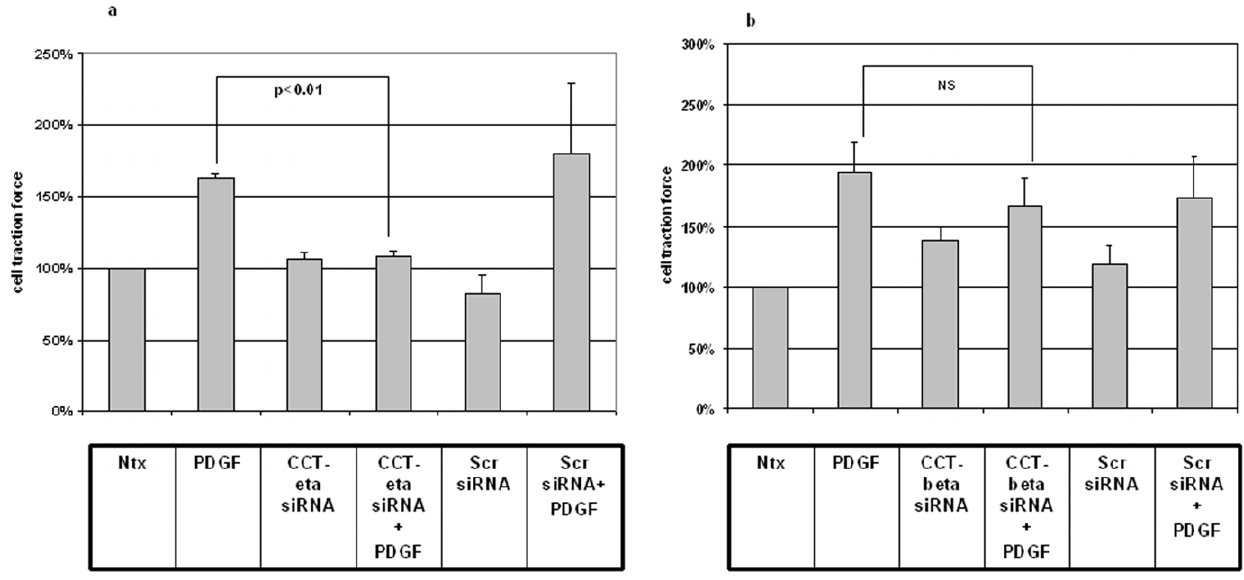
Figure 7. siRNA against CCT-eta but not CCT-beta reduces PDGF-induced cellular traction force in adult fibroblasts. Adult fibroblasts transfected with CCT-eta (a) or CCT-beta siRNA (b) along with pDSRed2-C1 were quantified for microdisplacement fields of red fluorescent cells on the green fluorescent substrate. Each assay was repeated twice with more than 30 cells quantified in each experiment. CCT-eta siRNA abolished the increased cellular traction force seen with PDGF treatment (200 nM), whereas CCT-beta siRNA and scrambled controls did not. Values are means 6 SEM of two independent experiments with statistical analyses performed using Student’s t test.